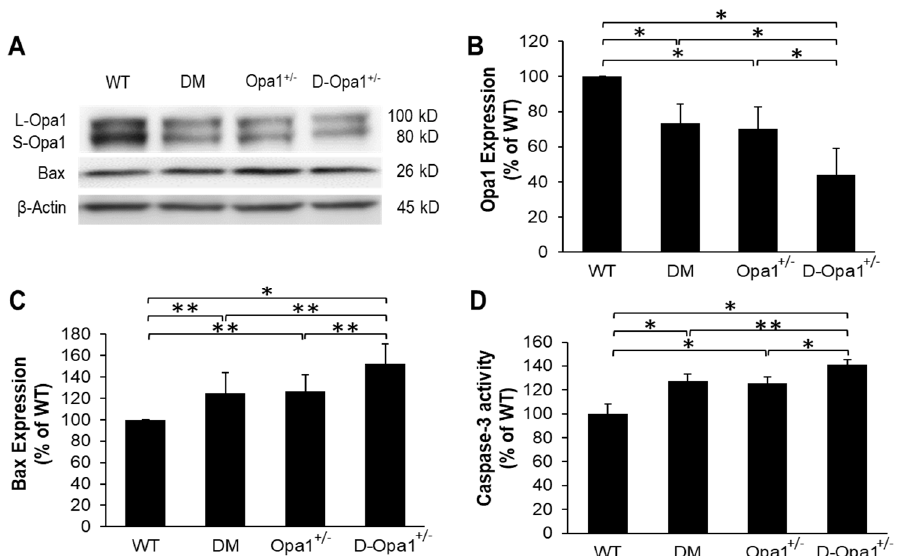
Figure 3. Reduced Opa1 expression increases Bax and caspase-3 activity in Opa1 +/ − mouse retinas. ( A ) Representative WB image shows Opa1 and Bax expression in the retinas of WT, diabetic (DM), Opa1 +/ − , and diabetic Opa1 +/ − (D- Opa1 +/ − ) mice. ( B ) Graphical illustration of cumulative data shows diabetes significantly downregulates Opa1 expression and that D- Opa1 +/ − exhibit further decrease in Opa1 expression. Graphical illustrations of cumulative data suggest reduced Opa1 levels in D- Opa1 +/ − mice promotes a diabetes-induced increase in ( C ) Bax levels and ( D ) caspase-3 activity. Data are expressed as mean ± SD. * p < 0.01, n = 6; ** p < 0.05, n = 6.